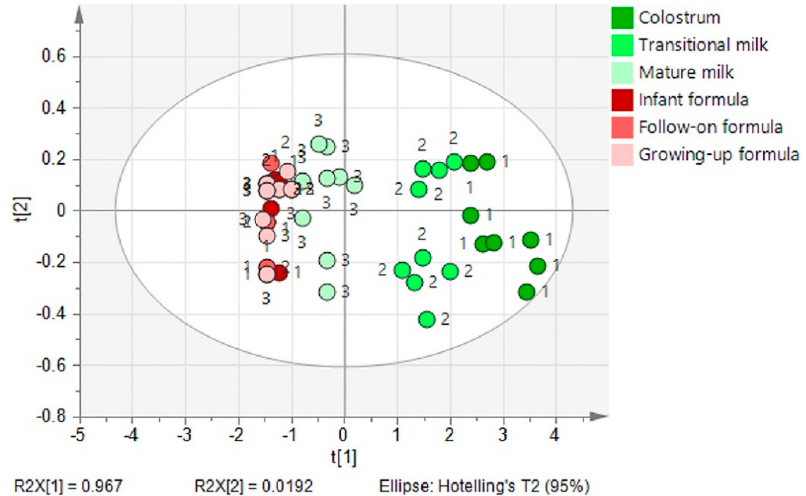
Figure5. Principalcomponentanalysisofstagedi ff Figure 5. Principal component analysis of stage difference in the NA content in human milk (1, colostrum; 2, transitional milk; 3, mature milk) and infant formulae (1, infant formula; 2, follow-on formula; 3, growing-up formula).